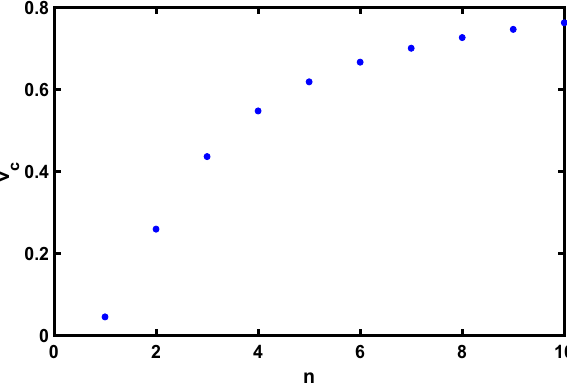
Fig. 19 Antikink-kink collision: critical velocity as a function of n